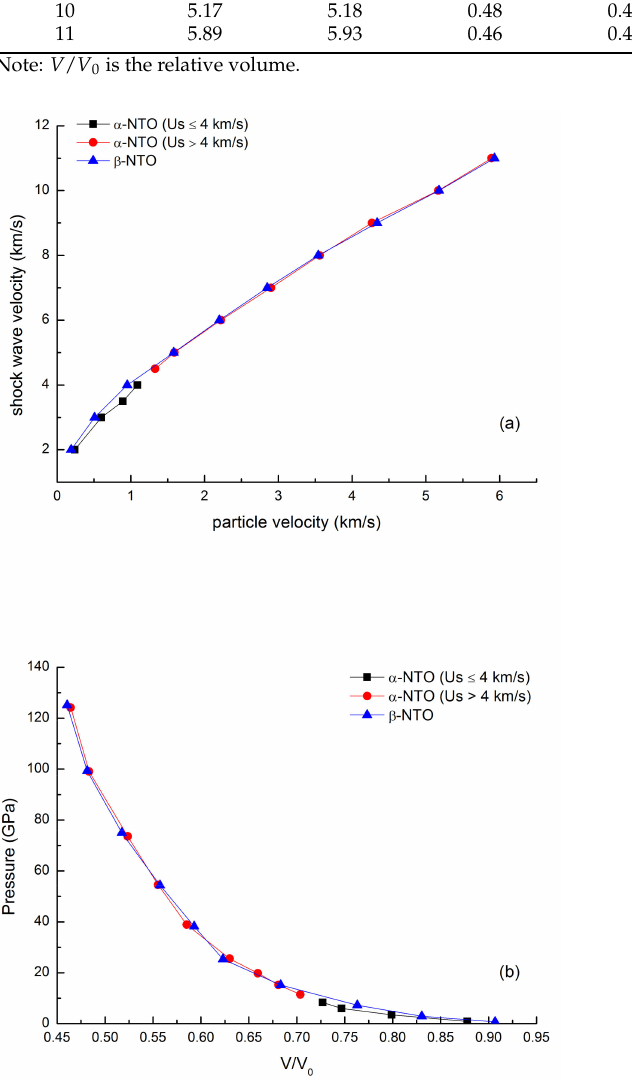
Figure 7. Shock Huoniot state data of α -NTO and β -NTO. ( a ) shock velocity and particle velocity relation; ( b ) pressure via relative volume along Hugoniot